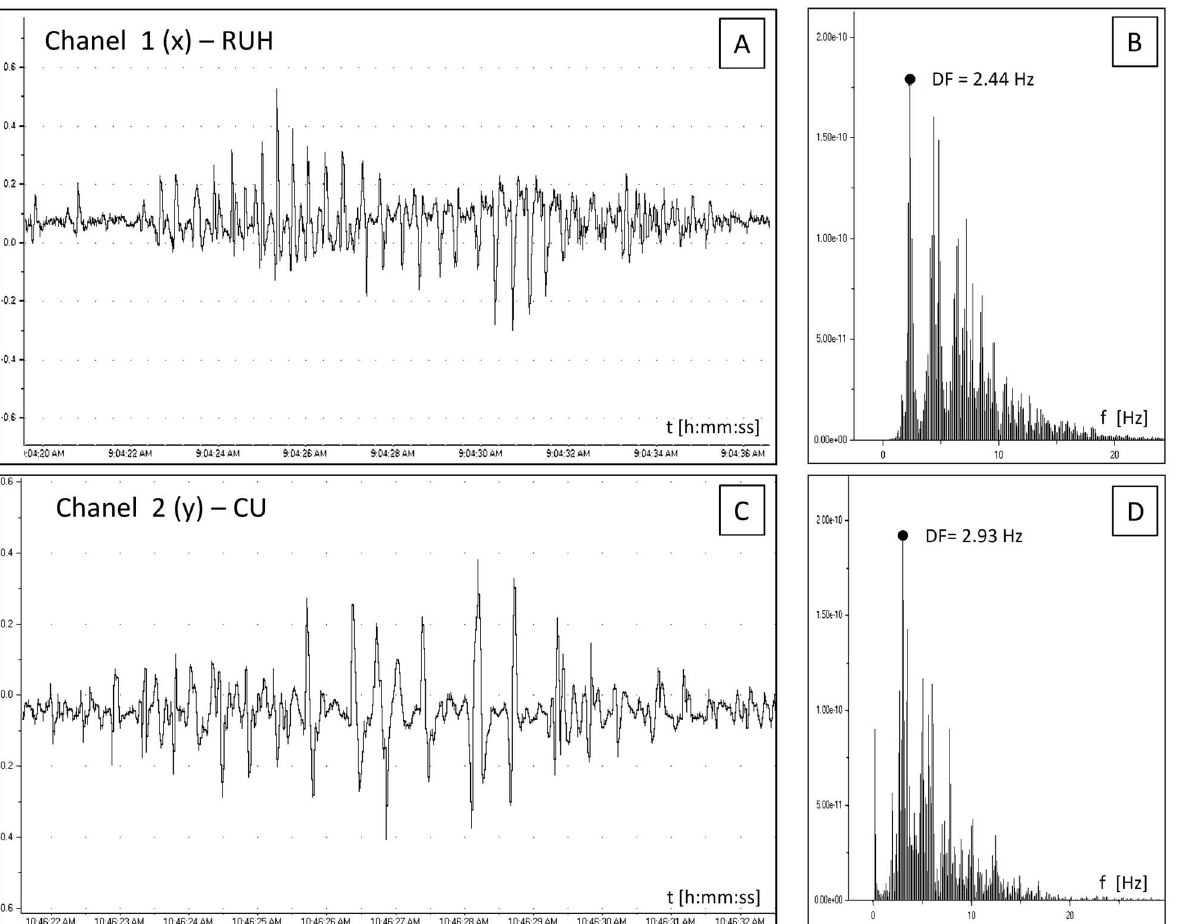
Fig 2. Fourier analysis of highly synchronized EMG signals. EMG signals from the right uterine horn (A, B) and corpus uteri (C, D) in time (A, C) and frequency (B, D) domains.